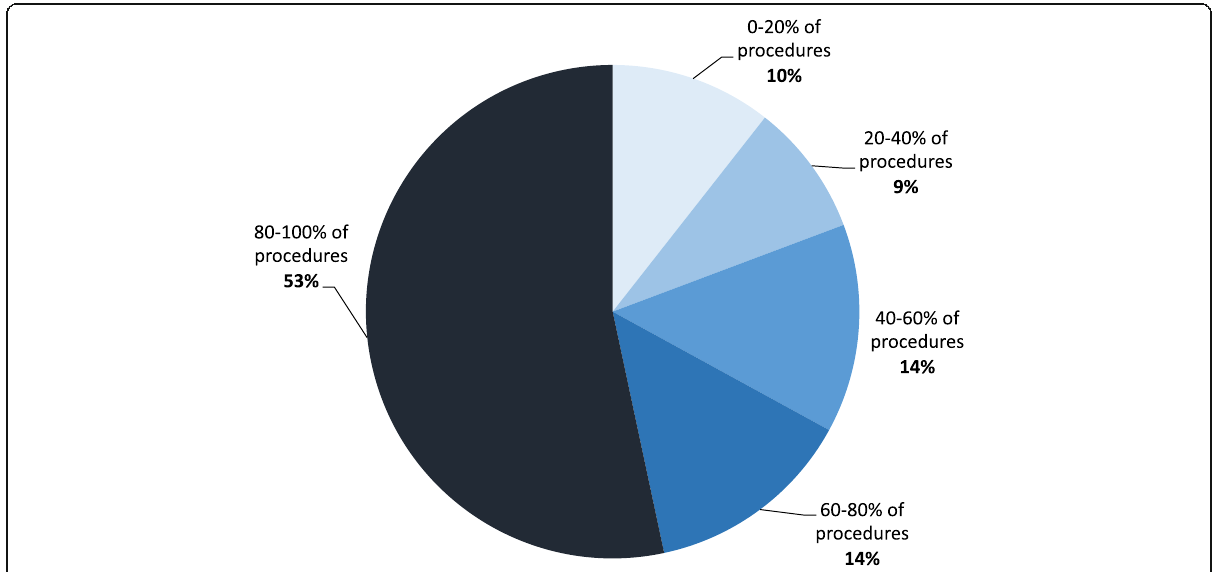
Fig. 3 Percentage of peripheral vascular interventions performed by IR at the respondents ’